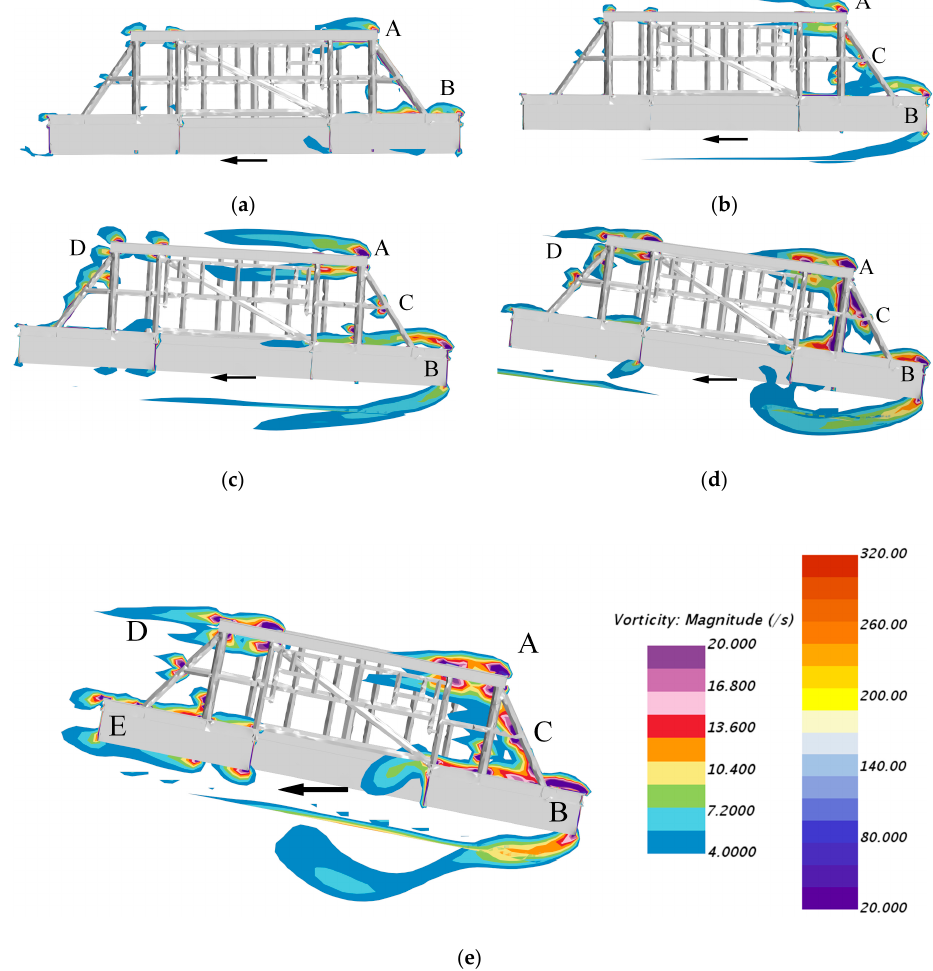
Figure12. Figure 12. Cross-sections of the vortex flow field colored according to vorticity magnitude for X-direction towing: ( a ) Case 1,